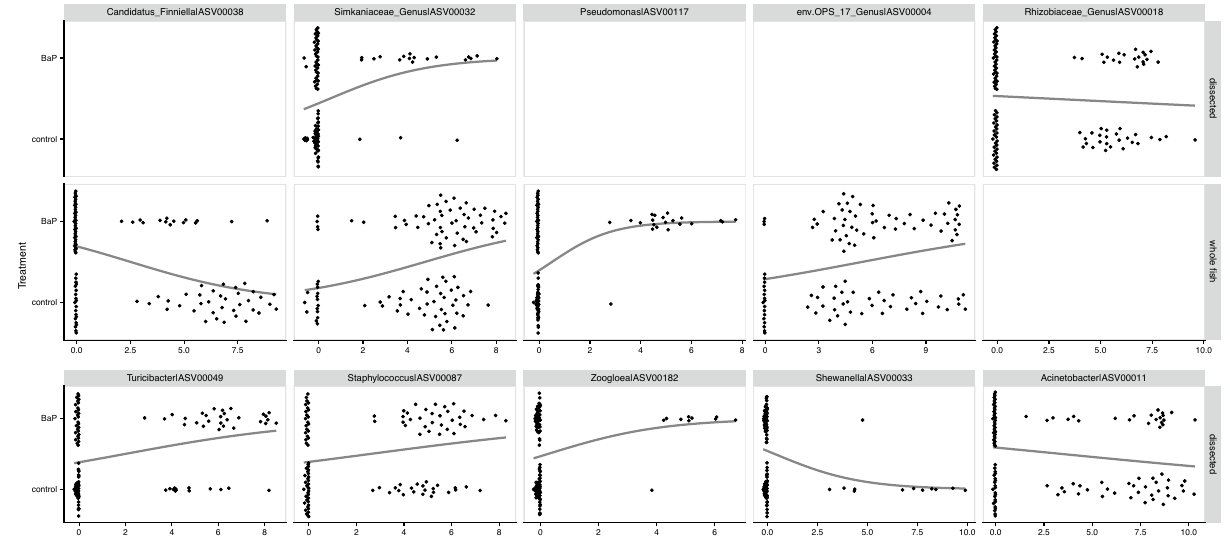
Figure 6. Swarm plots of logistic regressions predicting BaP exposure from individual ASV abundances (centered log-ratio transformed) using data subsets partitioned by dissection method. The top 10 taxa, ordered by importance according to the preceding random forest analysis are presented in this figure. Points indicate an ASV’s abundance per each dissection method. Black lines indicate the predicted relationship taken directly from the logistic regression